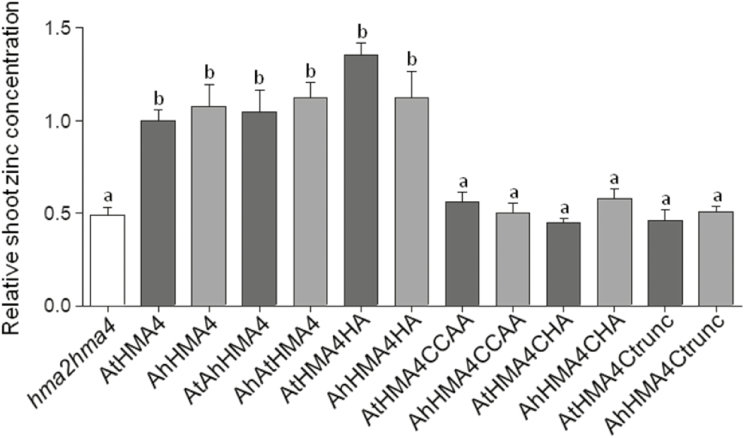
Zinc accumulation in complemented plants grown on soil. Non-transformed hma2hma4 mutant (white) and expressing the native or mutant A. thaliana (dark gray) or A. halleri (light gray) HMA4 proteins under the control of the AtHMA4 promoter were grown for 6 weeks on soil without zinc supplementation. Zinc concentrations were measured in shoot tissues collected from two plants per line. Values are relative to lines expressing the native AtHMA4 proteins and are means±SEM of four to eight homozygous T3 independent lines for each genotype. The data were analysed with one-way ANOVA followed by Tukey’s multiple comparison test. Statistically significant differences (P<0.05) between means are indicated by different letters. Ah, A. halleri; At, A. thaliana; AtAhHMA4 and AhAtHMA4, swapped C-terminal extensions; HA: His- → Ala-stretch; CCAA: di-Cys → di-Ala motifs; CHA: HA and CCAA mutations combined; Ctrunc: fully truncated C-terminal extension.